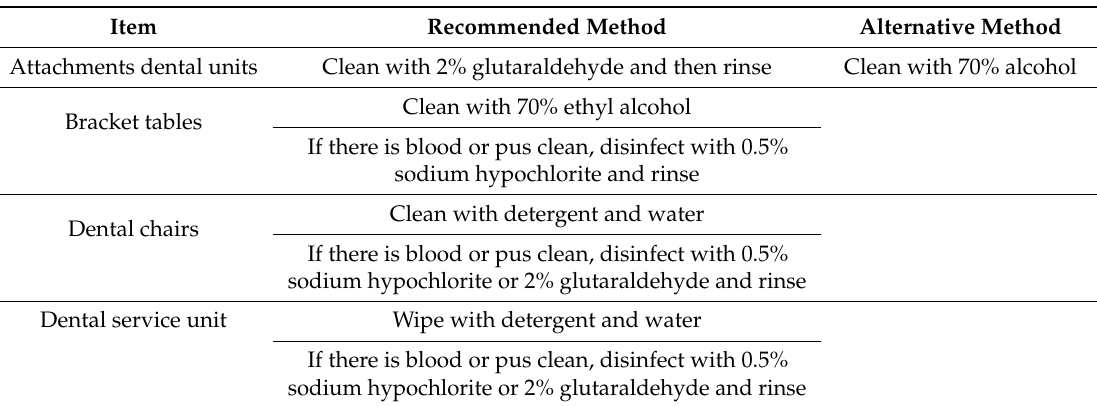
Table 6. surface disinfection table.